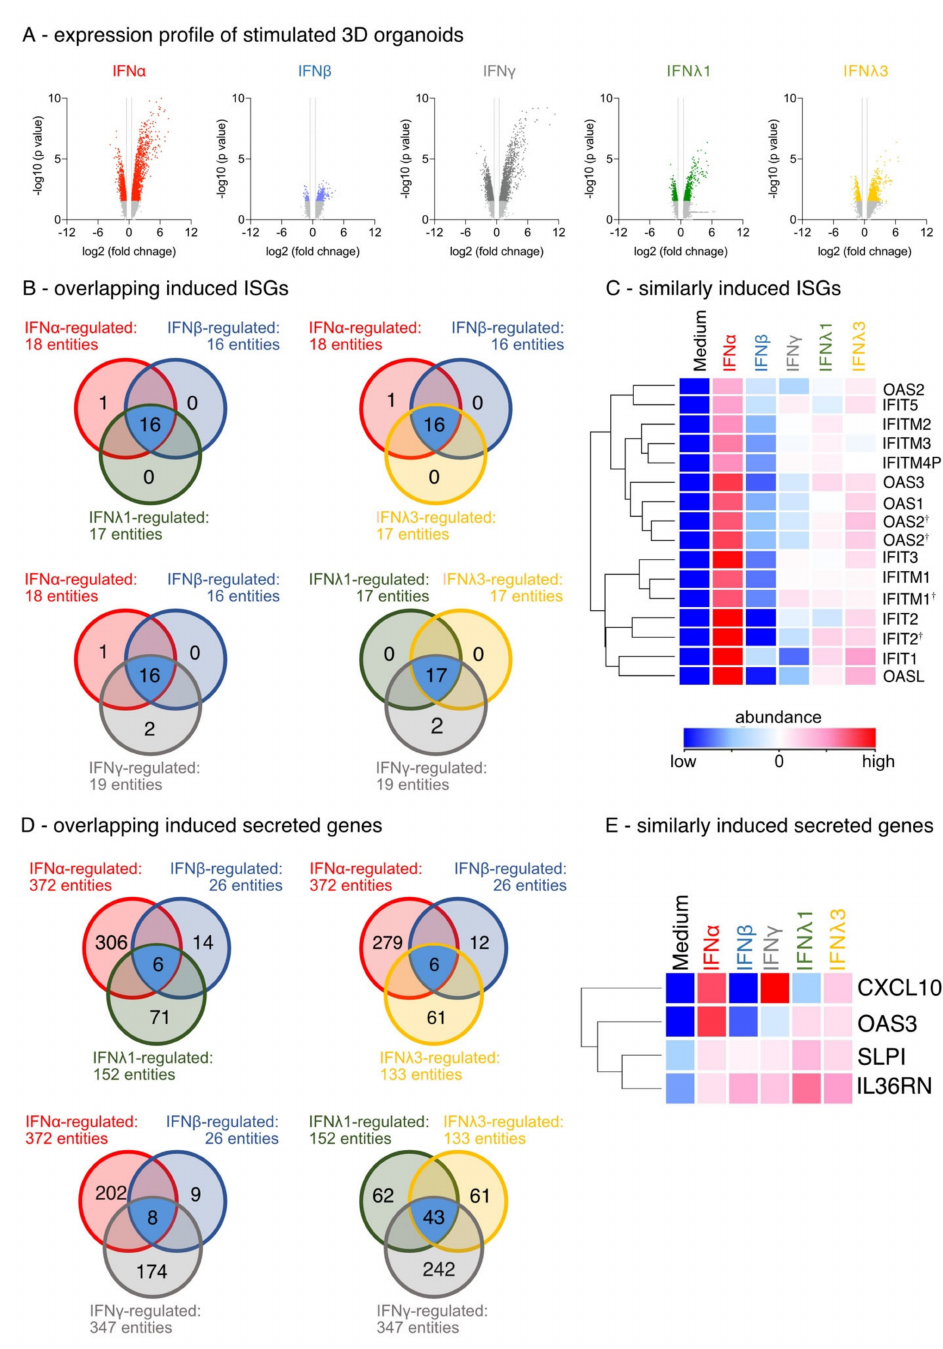
Figure 2. Expression profile of IFN-stimulated differentiated organotypic 3D air-liquid interface cultures. ( A ) Volcano Blot of regulated genes (fold change (FC) ≥ 1.5; p < 0.05). Red: ttest IFN α - stimulated vs. unstimulated, blue: ttest IFN β -stimulated vs. unstimulated, grey: ttest IFN γ - stimulated vs. unstimulated, green: ttest IFN λ 1-stimulated vs. unstimulated, yellow: IFN λ 3- stimulated vs. unstimulated. ( B ) Venn blot of overlapping regulated ISGs by type-I, -II, and -III IFNs. Ttest IFN α -stimulated vs. ttest IFN β -stimulated and ttest IFN λ 1-stimulated. Ttest IFN α -stimulated vs. ttest IFN β -stimulated and ttest IFN λ 3-stimulated vs. unstimulated. Ttest IFN α -stimulated vs. ttest IFN β -stimulated and ttest IFN γ -stimulated. Ttest IFN λ 1-stimulated vs. ttest IFN λ 3-stimulated and ttest IFN γ -stimulated. Blue: overlapping DEGs. ( C ) Heat map of overlapping upregulated ISGs by type-I, -II, and -III IFN. Duplicate gene names indicate the abundance of two or more transcripts of the same gene in the analysis and are marked with a cross. ( D ) Venn blot of overlapping regulated secreted factors by type-I, -II, and -III IFNs. ( E ) Heat map of overlapping upregulated secreted factors by type-I, -II, and -III